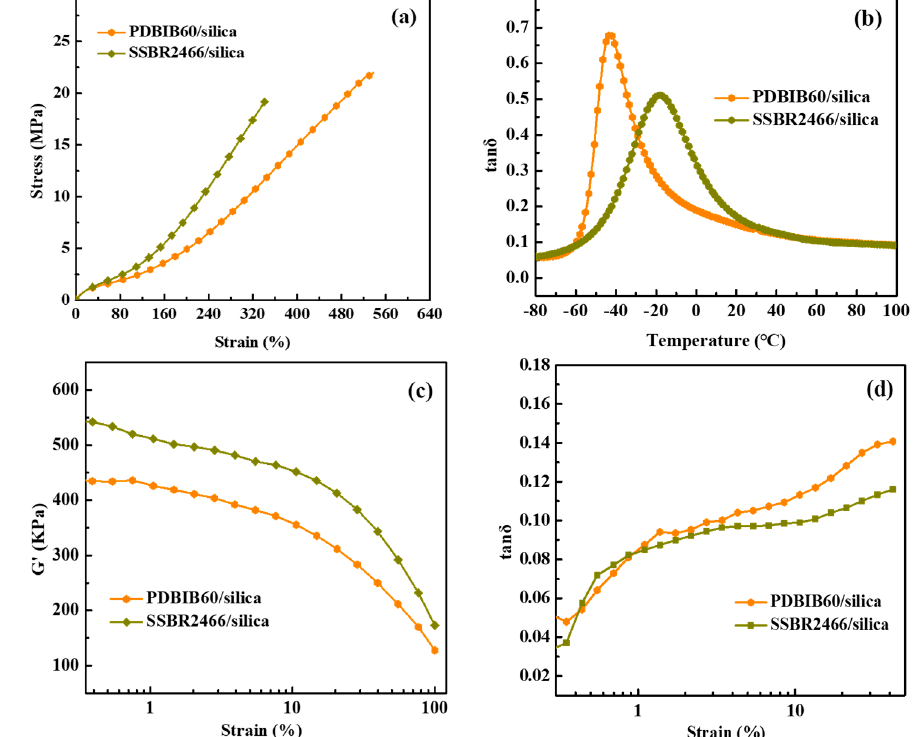
Figure 14. Performance comparison of PDBIB and SSBR: ( a ) mechanical properties, ( b ) dynamic mechanical properties, and ( c , d ) strain dependence of storage modulus and loss tangent (tan δ ).